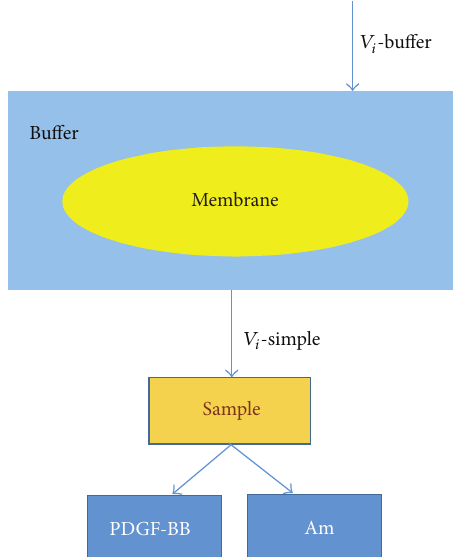
Figure 2: Diagram of the release of PDGF-BB and Am from